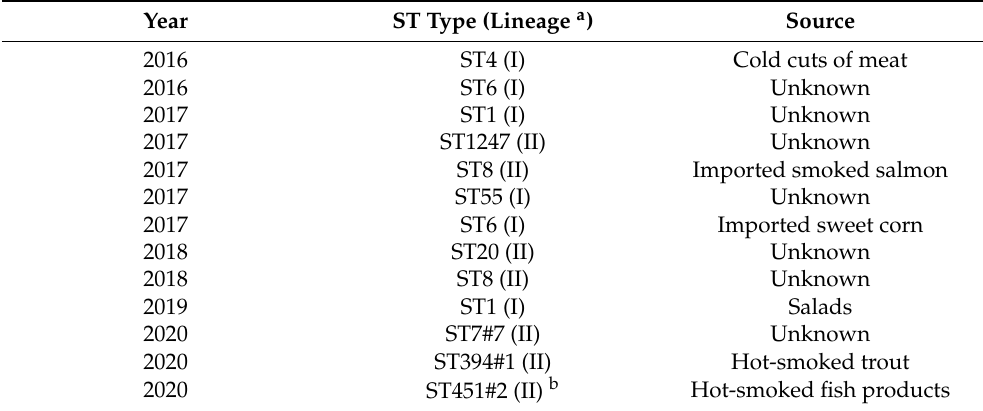
Table 4. Listeria monocytogenes outbreak isolates (ST and source) as reported in the Food- and Waterborne Outbreak Database published in the Annual Report on Zoonoses from 2016–2020 [2,34–37]. Year ST Type (Lineage a